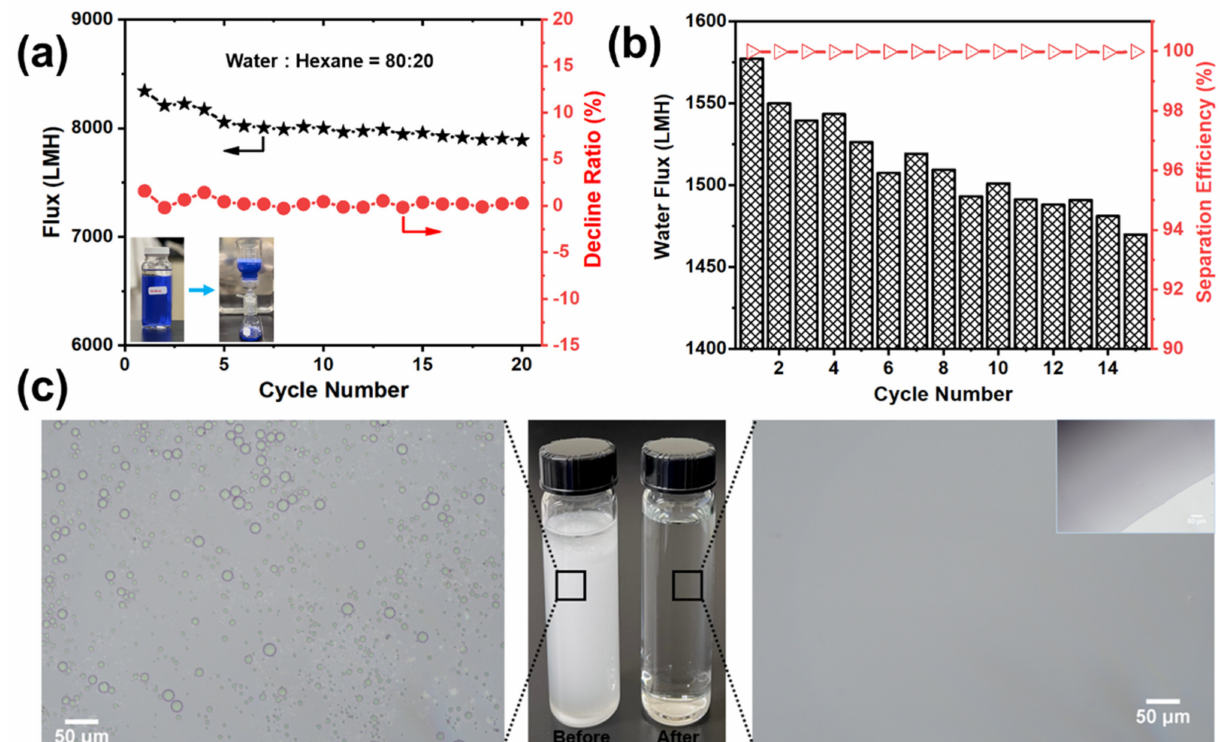
Figure 9. ( a ) Flux recovery and ratio of decline of the EVOH membrane with increasing cycle number. Oil–water emulsion separation results of the 27EVOH_22% membrane: ( b ) Flux and separation efficiency of emulsion through the membrane and ( c ) Optical microscopy images of the emulsion before and after separation. The inset is an image of a permeate water drop near the boundary